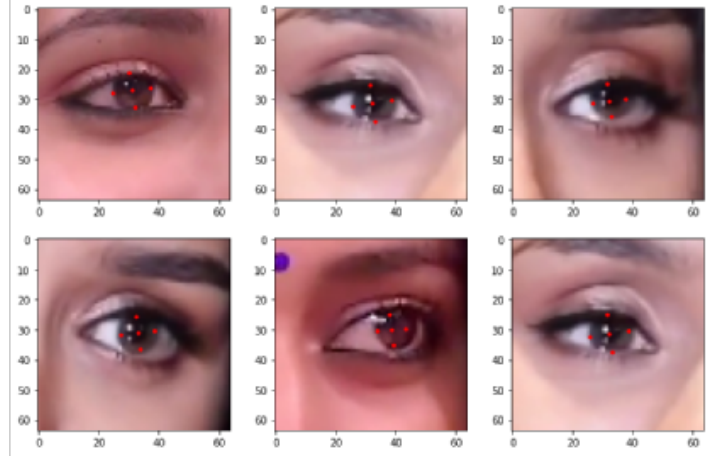
Figure 5. Prediction of iris landmarks of the proposed model.